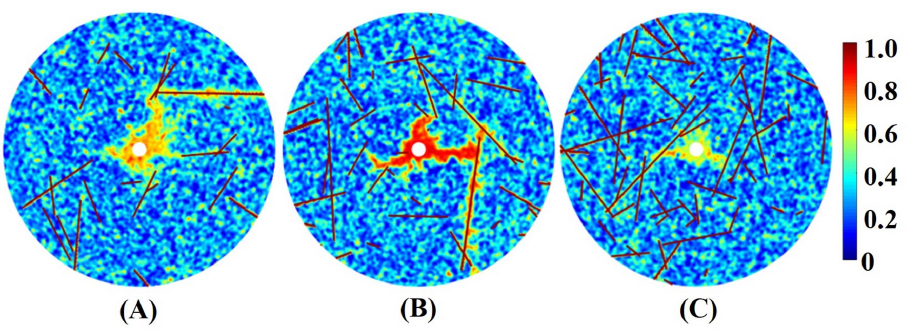
Figure 7. Influence of fracture density on wormhole structures, the number of fractures: ( A ) 20; ( B ) 35; ( C )